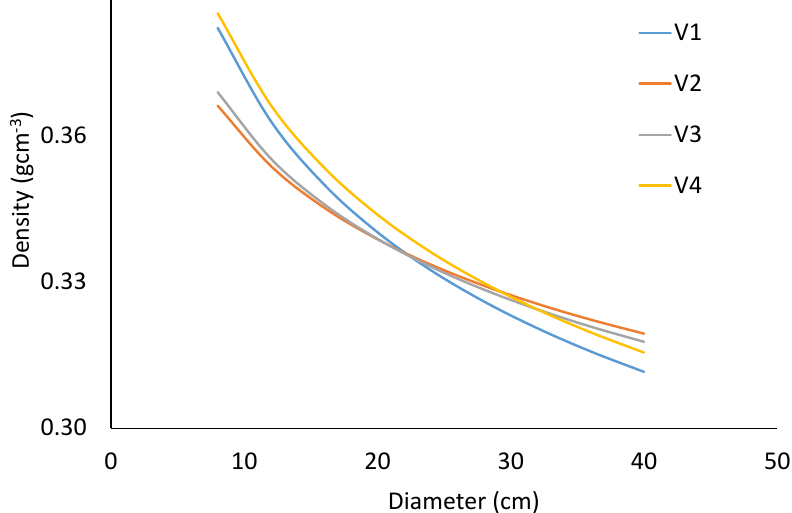
Figure 3. Average density curves in relation with diameter and plantation variant.